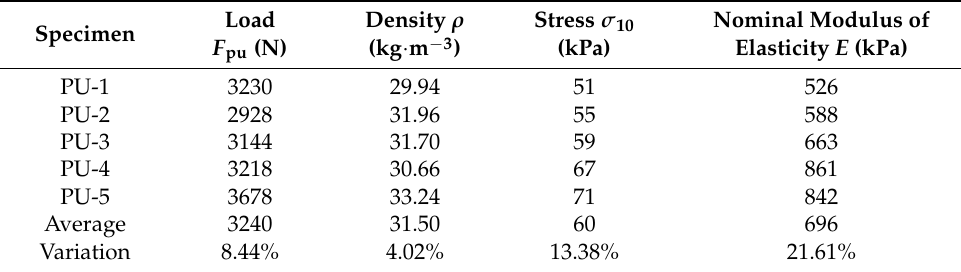
Table 2. Results of the static compression test for polyurethane foam.